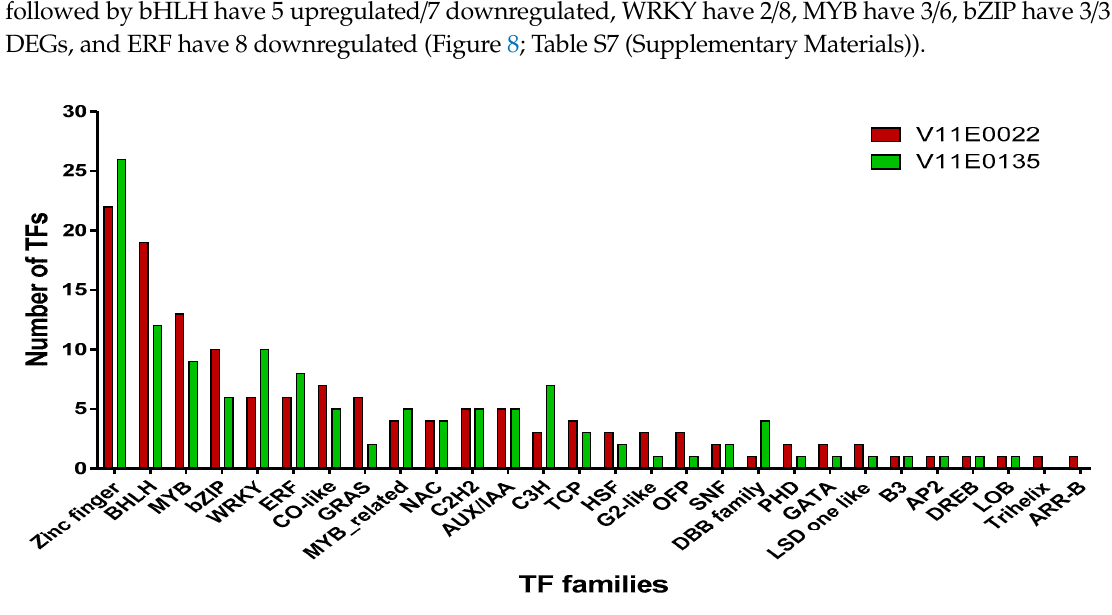
Figure 8. Distribution of differentially expressed transcription factors in two cultivars of water dropwort under salt stress.